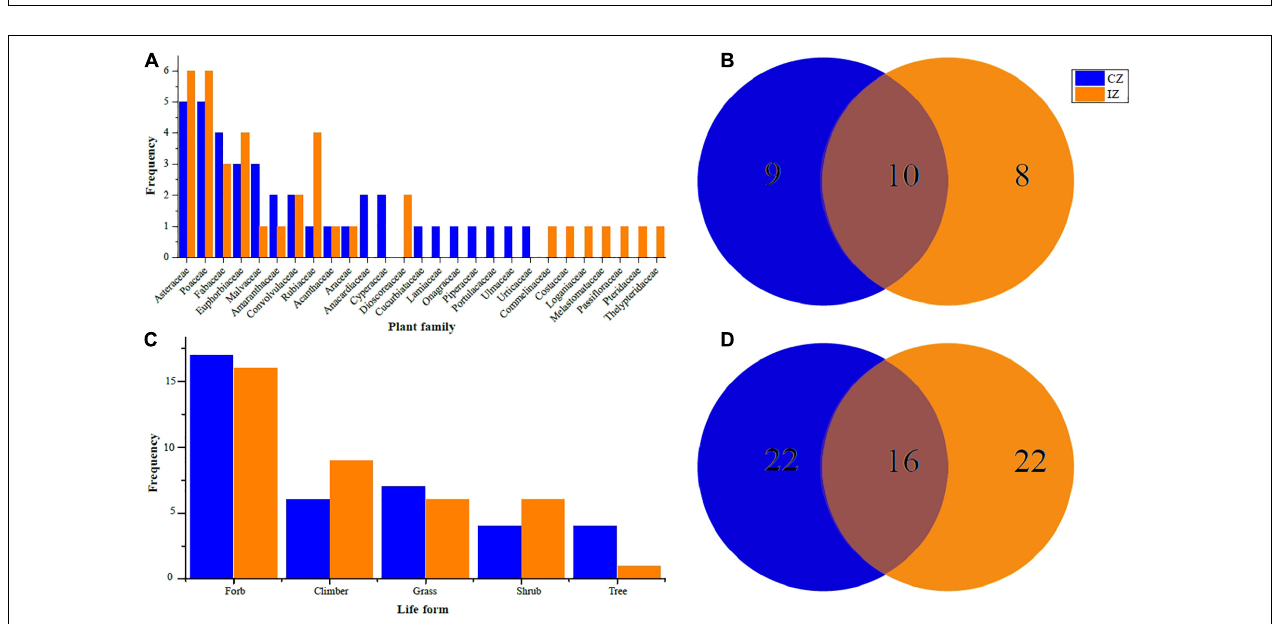
FIGURE 3 | Comparative Species distribution of the study area. (A) Family, (B) number of unique families, (C) life form, and (D) the number of unique species.